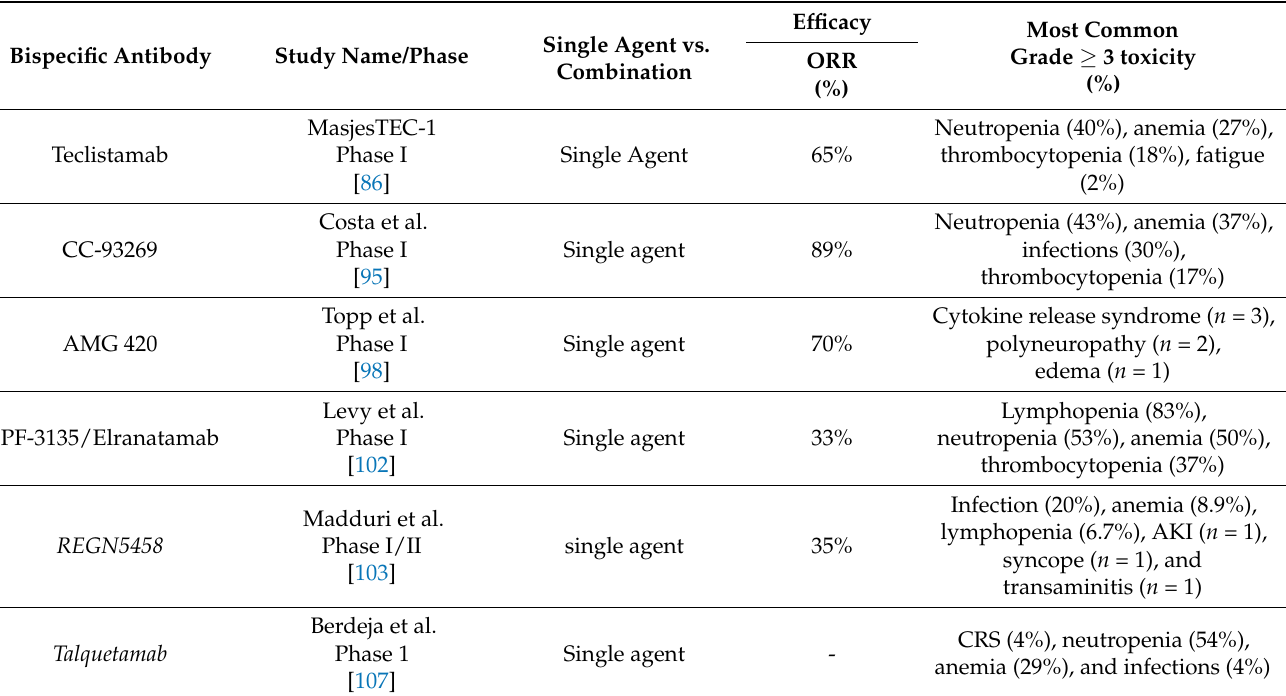
Table 3. Bispecific antibody summary of efficacy and grade 3 adverse events for treatment of multiple